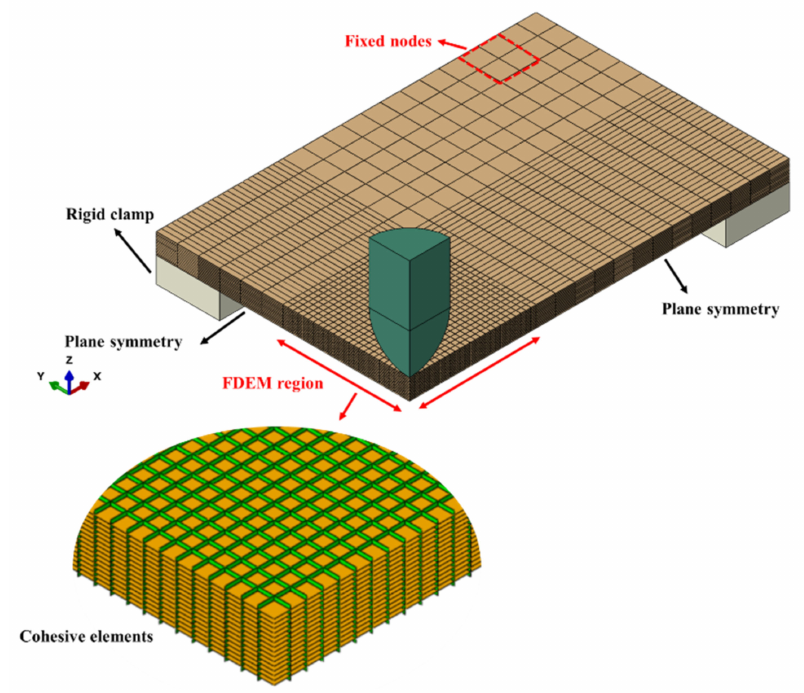
Figure 5. The overall 3D FDEM model with a zoomed view of the cohesive